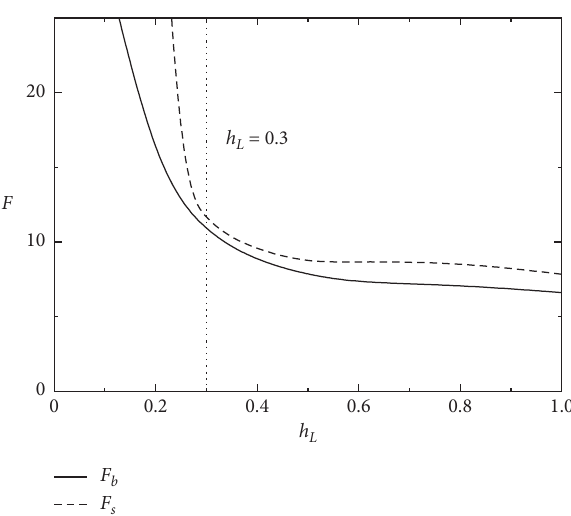
Figure 12: Effect of the height of the left leg ( h load ( F b ) and the snap through load ( F s ) of a portal frame